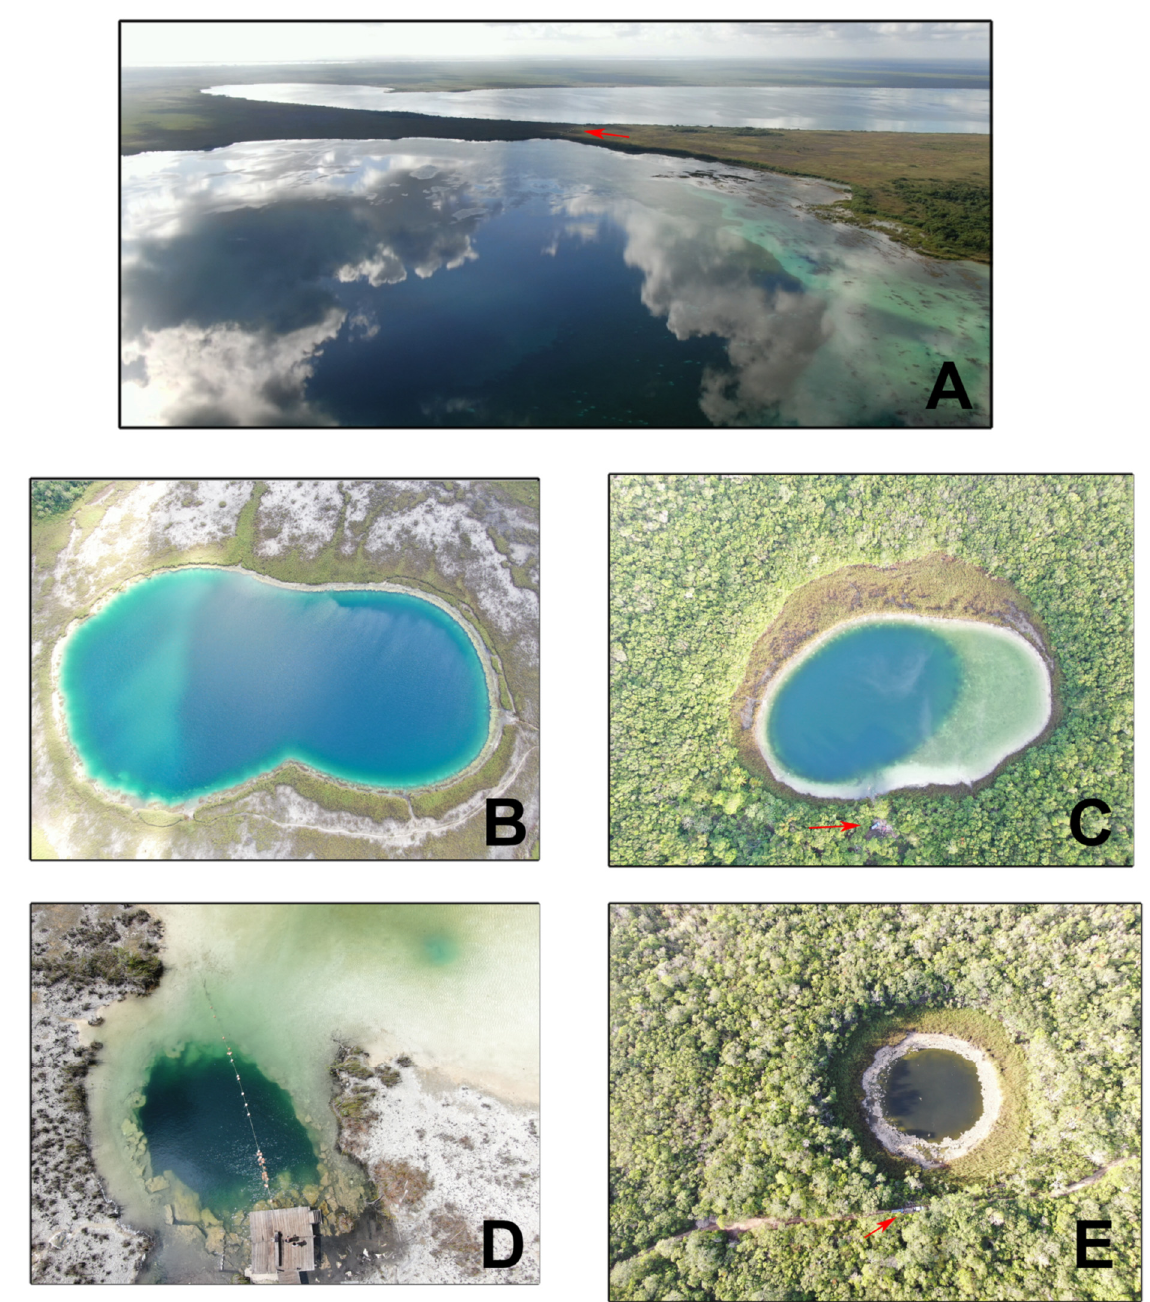
Figure 2. Aerial photographs of some of the studied systems. ( A ) Laguna Muyil. At the bottom is the Chunyaxché lagoon. The arrow points to the ancient channel that communicates both systems. ( B ) Km 48, surrounded by dried wetlands. ( C ) Del Padre sinkhole. Notice the surrounding vegetation. Arrow points to a car for scale. ( D ) Sijil Noh Há sinkhole inside of a lagoon with the same name. ( E ) Tres Reyes 1 sinkhole. This system is the only eutrophic water body studied, as the color of the water indicates. Arrow points to parked cars. Notice the influence area and the surrounding vegetation. All photographs were taken by Manuel Elías-Gutiérrez.